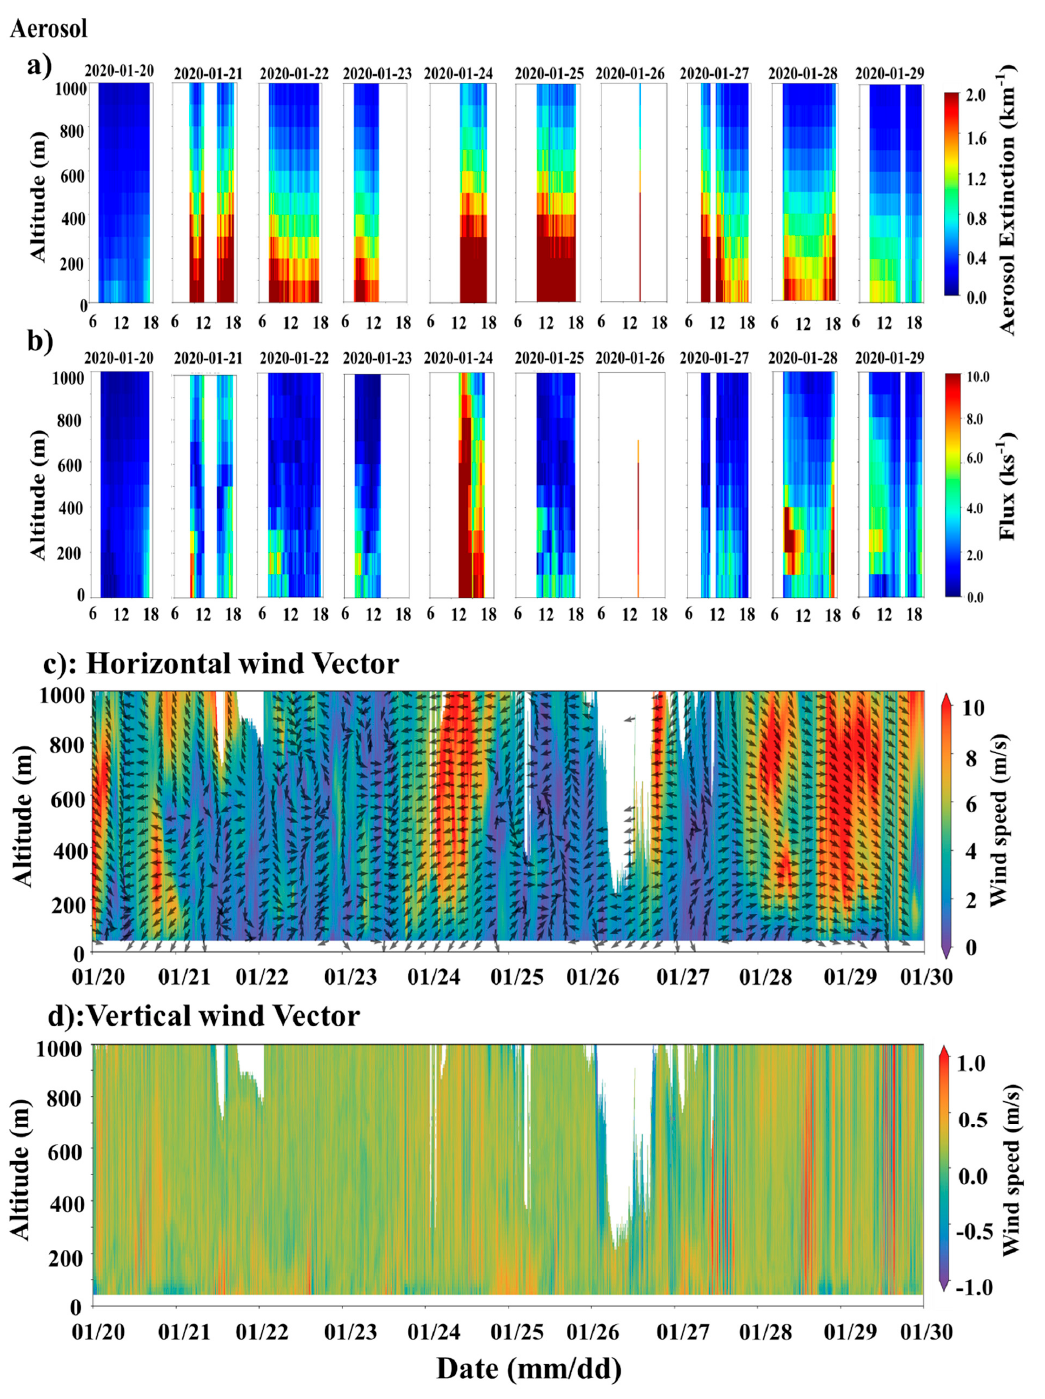
Figure 9. Spatial variations in pollutant profiles, transport flux profiles and wind profiles from 20 January 2020 to 29 January 2020. ( a ) Aerosol extinction profiles, ( b ) horizontal transport flux of aerosol extinction profiles, ( c ) horizontal wind vectors (colors represent speed and arrows represent direction with respect to the north) and ( d ) vertical wind vectors (positive means upwelling, negative means downwelling).